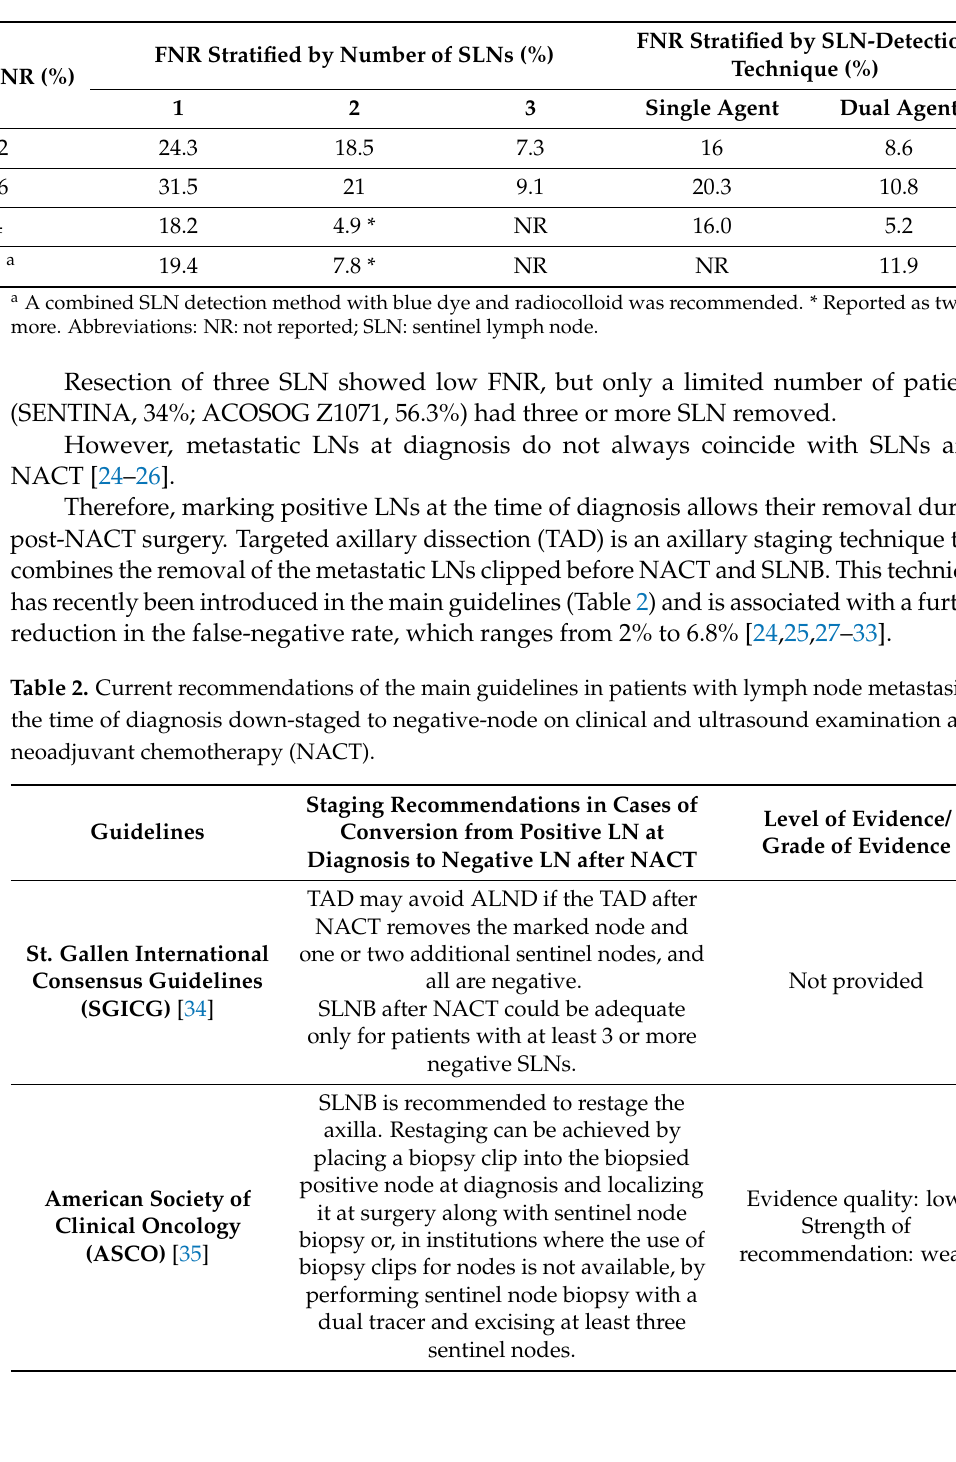
Table 1. False-negative rates (FNR) for SLNB in cases of conversion from positive LN at diagnosis to negative LN after NACT.